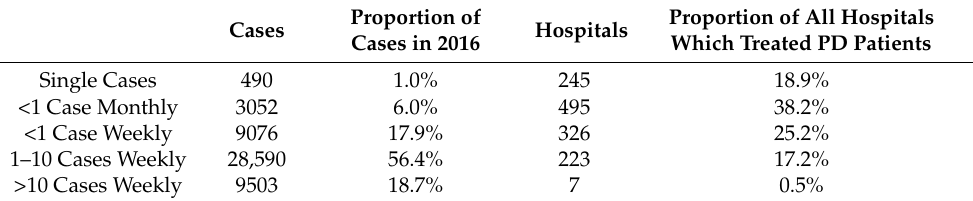
Table 5. Number of cases per year and hospital for inpatient treatment of PD and other basal ganglia disorders (ICD. G20–G23) grouped into quantitative classes for the year 2016.